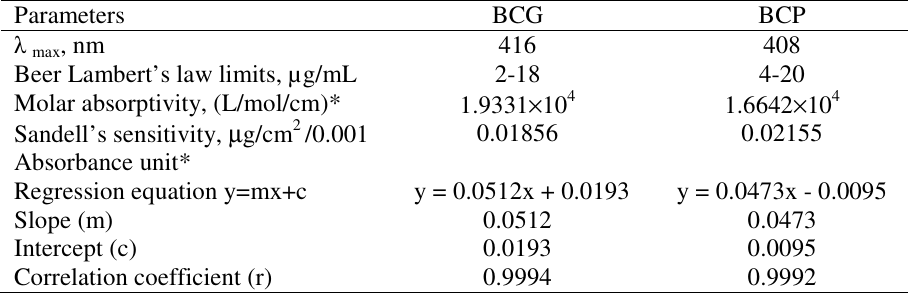
Table 2. Optical characteristics.